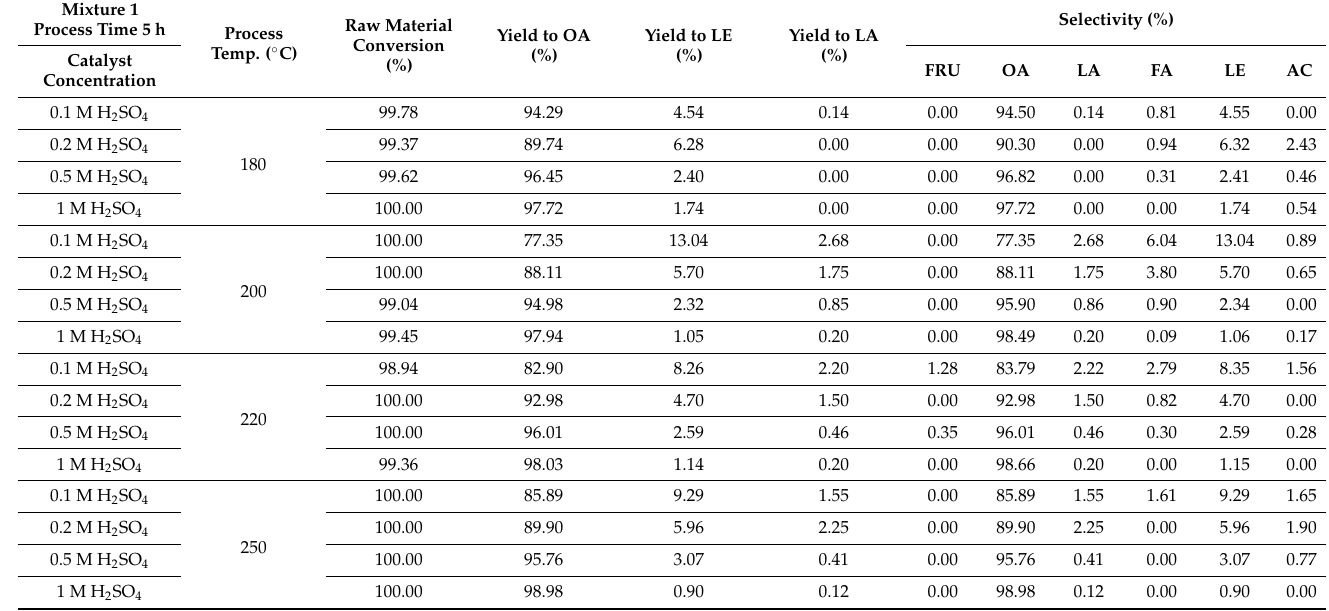
Table 4. The results of HPLC analysis for the catalytic conversion of hemicellulose carbohydrates using the homogeneous H 2 SO 4 catalyst in the liquid phase, with a 5 h process time for mixture 1.